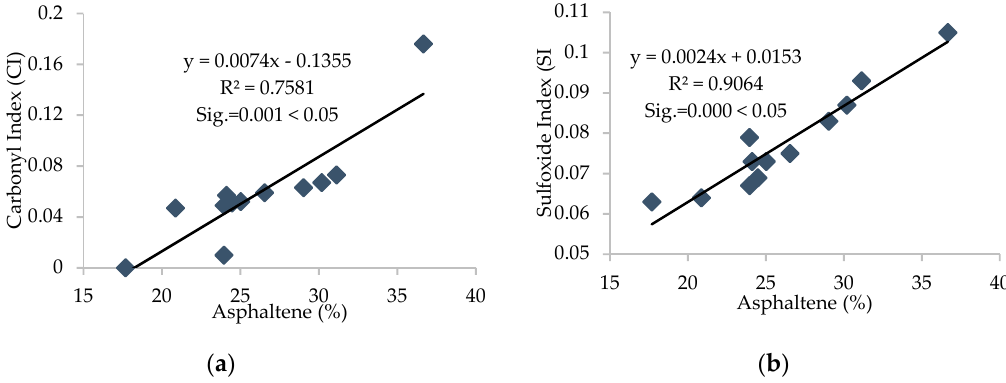
Figure 14. ( a ) Correlation between FTIR indices and ( b ) asphaltene content of all samples of binders.